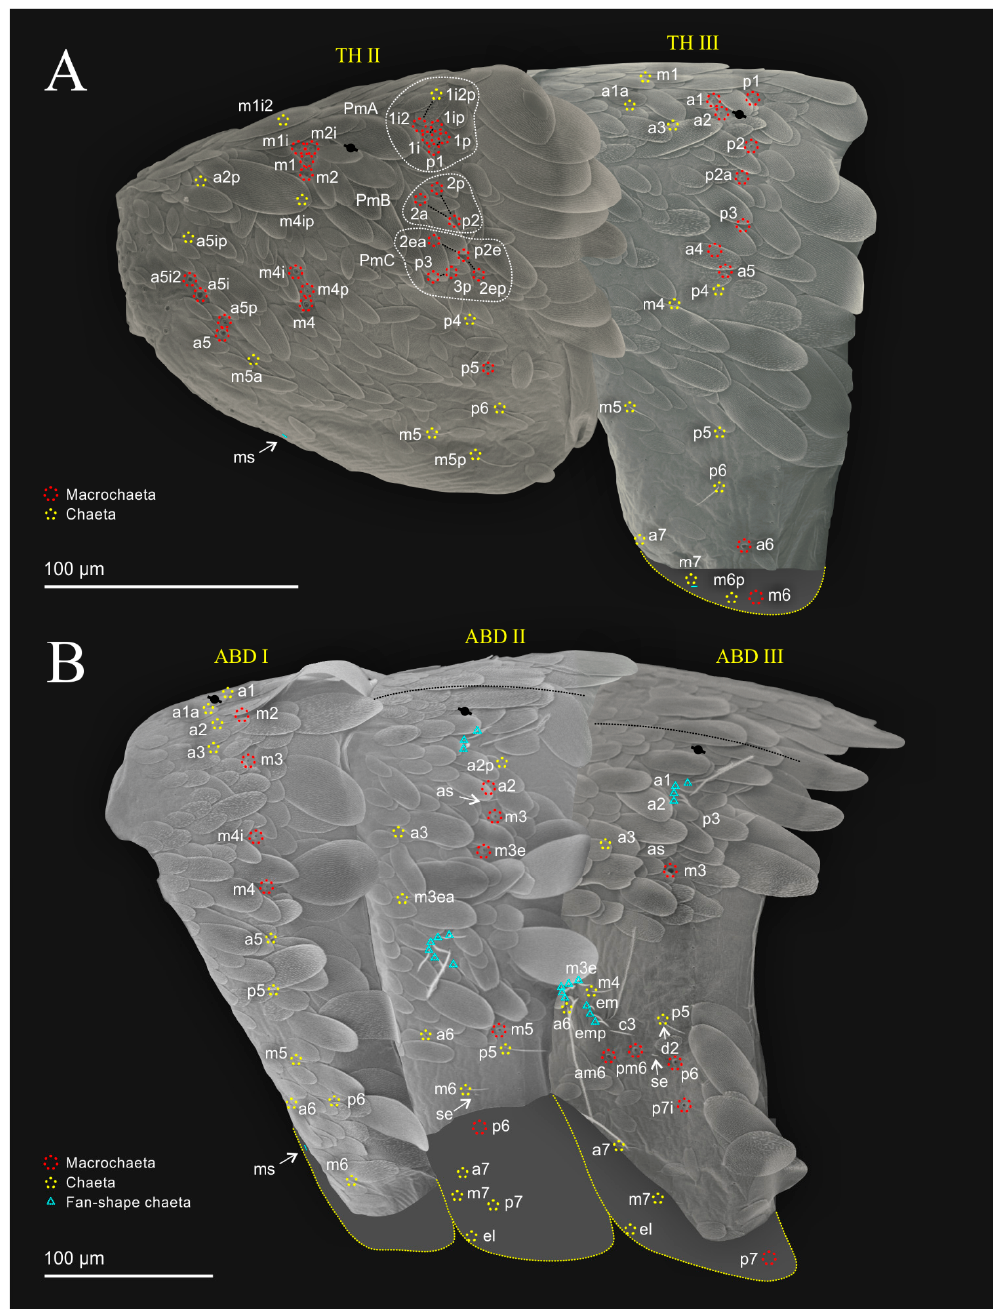
Figure 10. Seira musarum SEM: body chaetotaxy: ( A ), thorax II and III; ( B ), abdomen I to III. Abdomen chaetotaxy (Figures 9 and 10). Abd I: a, m and p series with six mic (a1, a1a, a2, a3, a5 and a6), four mac (m2, m3, m4i and m4), two mic (m5—6) and two mic (p5–6), respectively. Abd II: a, m and p series with four mic (a2p, a3 and a6—7), one mac (a2),